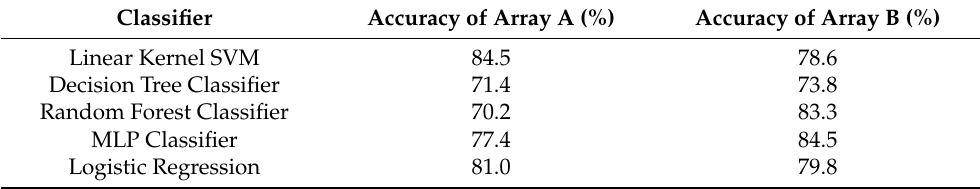
Table 3. Machine recognition results at an abnormal temperature of 270 °C.